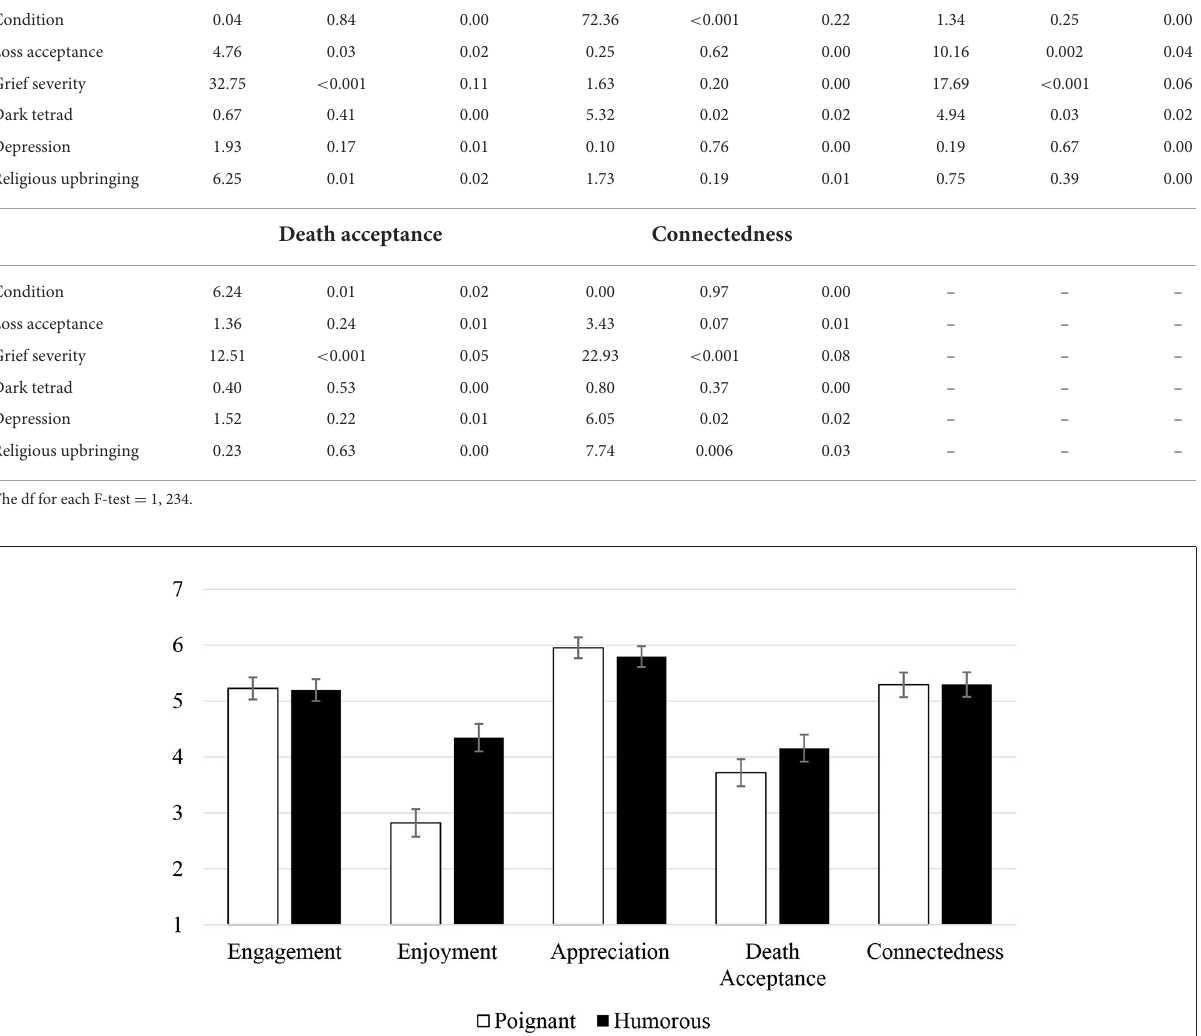
Peters (2022) and echo our findings regarding appreciation. Given the fact that connectedness was high in both conditions,